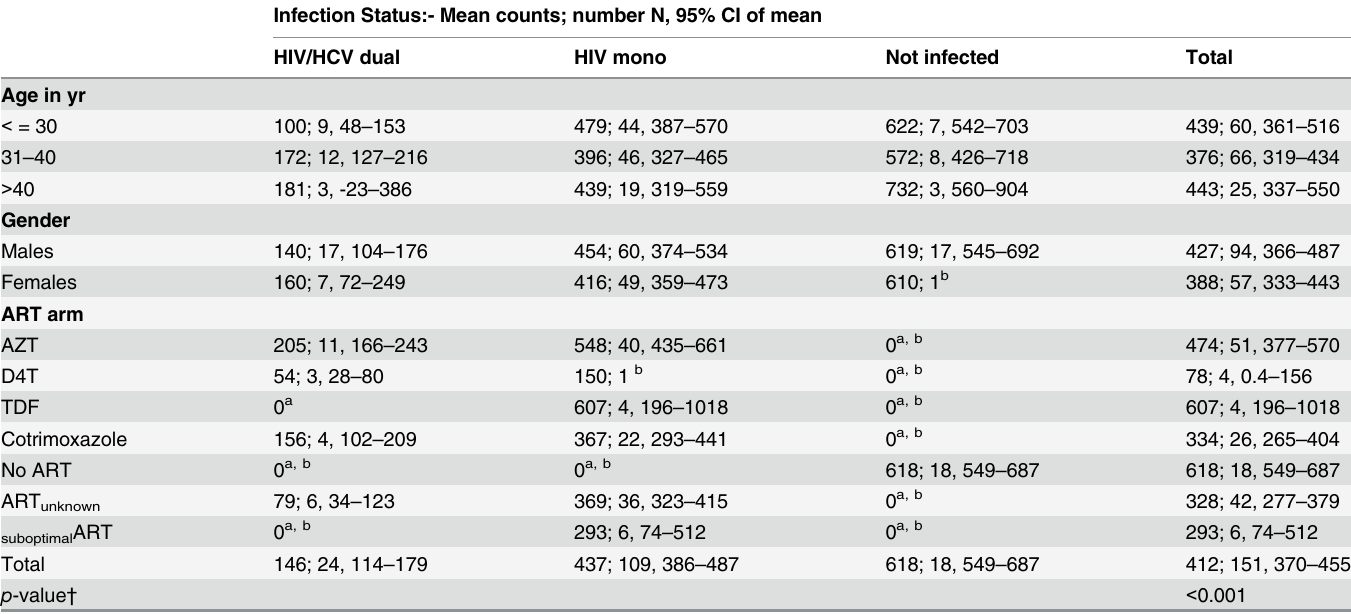
Table 3. CD4 T-cell counts compared by various categories of heroin injectors who were screened for both HIV and